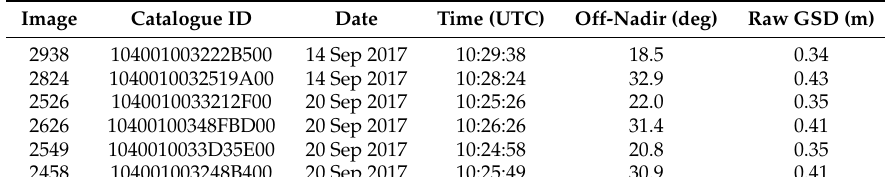
Table 1. List of the WorldView-3 images used for the experimentation, with date and time of acquisition, off-nadir angle and average raw ground sample distance of the scene.